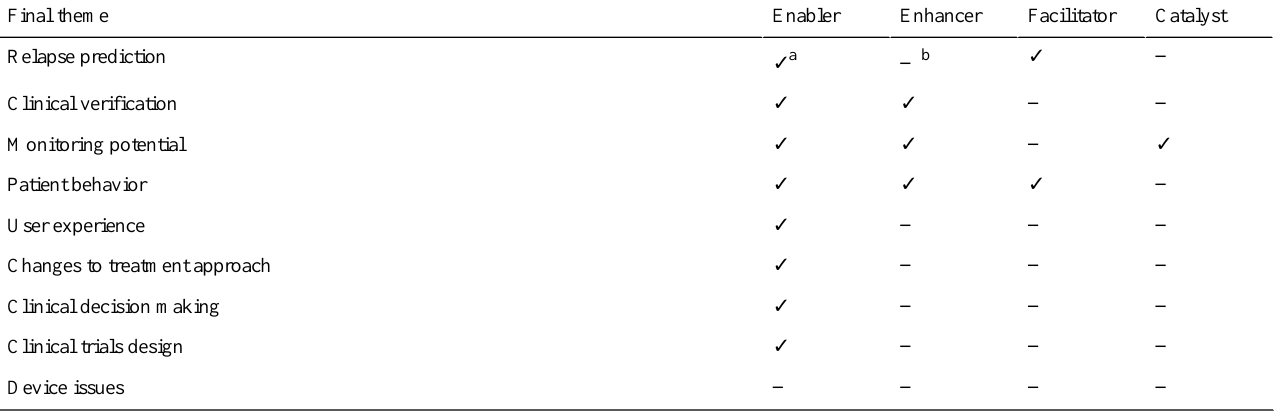
Table 3. Themes derived from section B concerning the promise of remote measurement